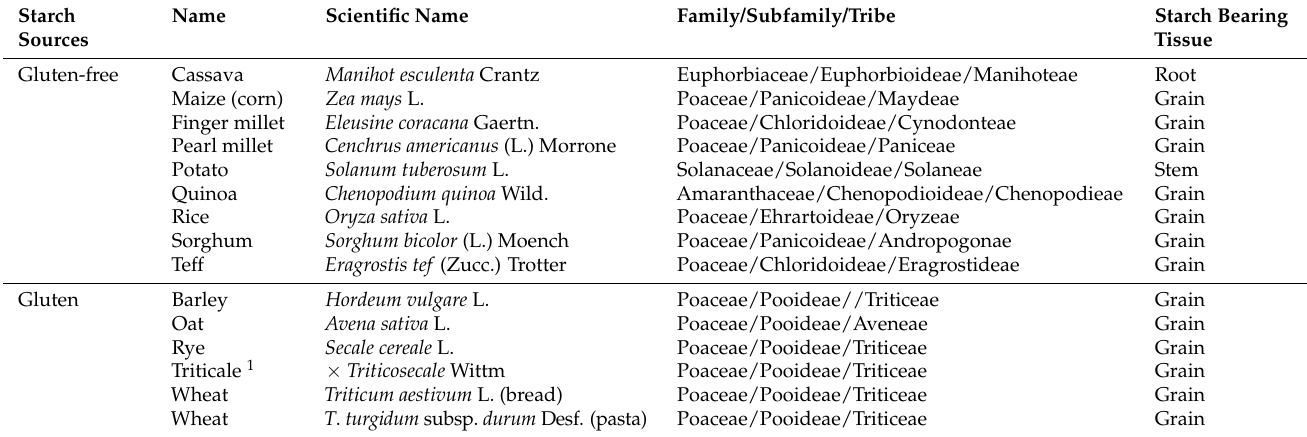
Table 1. Primary caloric sources for humans from starch with and without